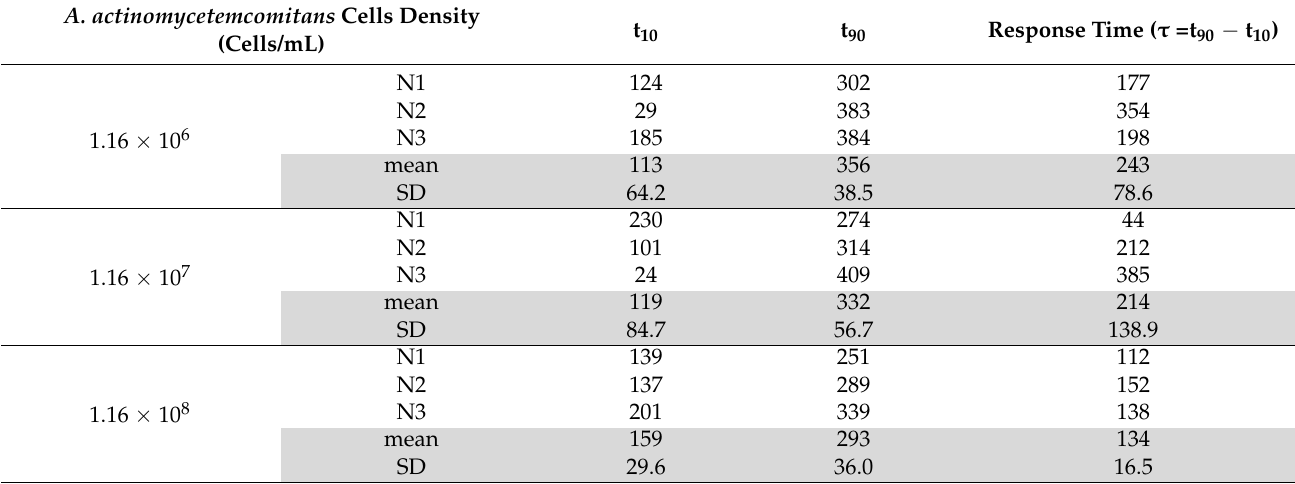
Table 2. Response time of the binding between A. actinomycetemcomitans cells and Anti- A. actinomycetemcomitans antibody. A. actinomycetemcomitans Cells